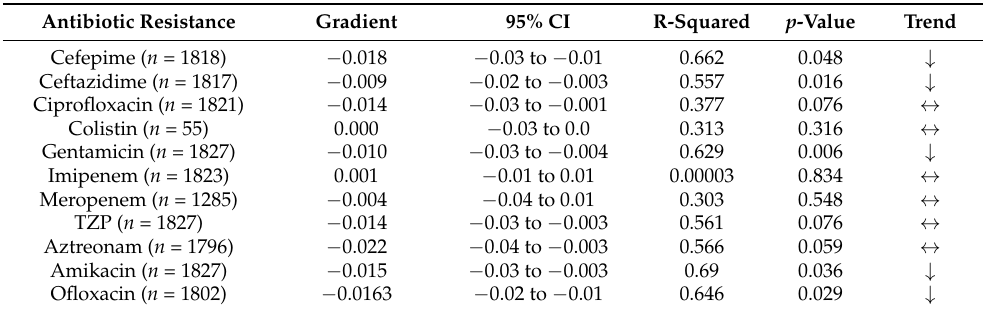
Table 1. Trends of Pseudomonas resistance to